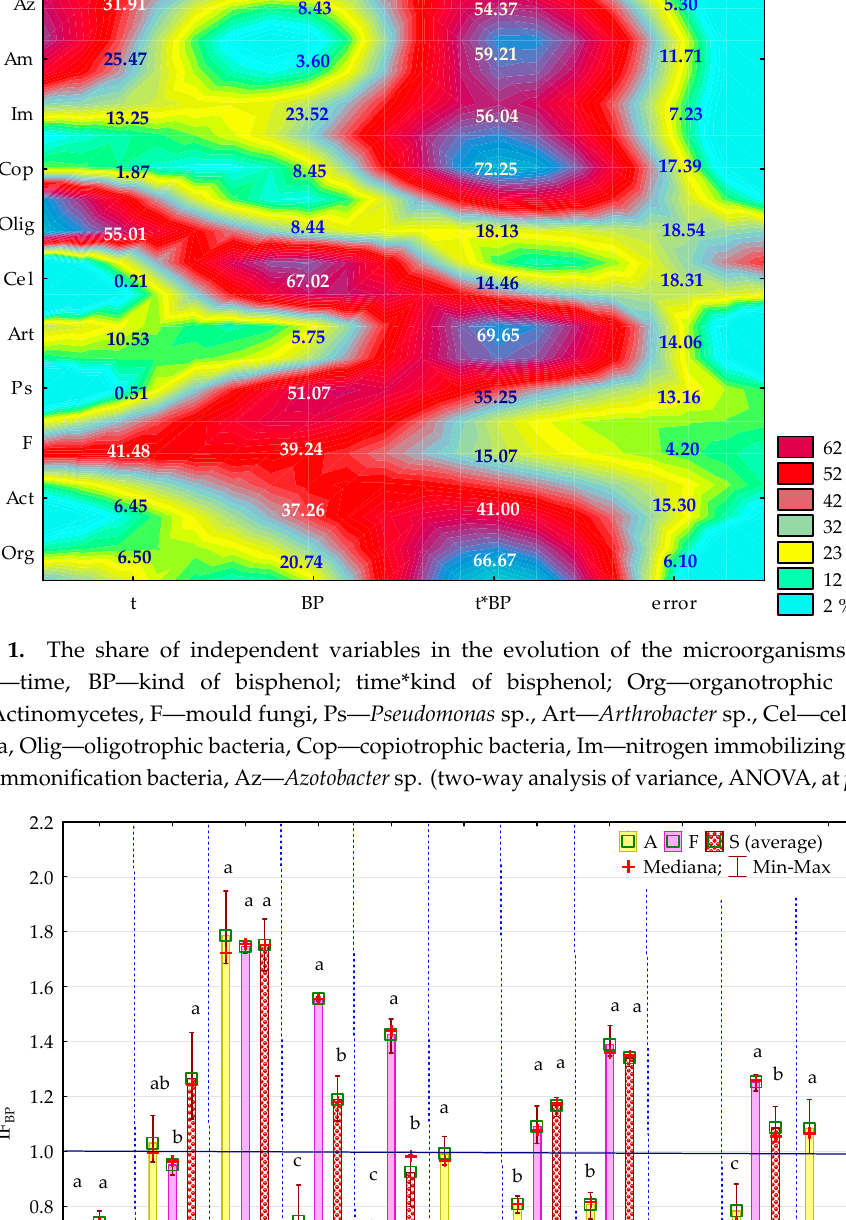
a Figure 3. Coefficient of impact (IF BP ) of bisphenols for group of microorganisms in soil contaminated with BPA, BPF and BPS on the 30th day of research; Homogeneous groups denoted with letters (a–c) were calculated separately for each group of microorganisms (for abbreviations see Figure 1).